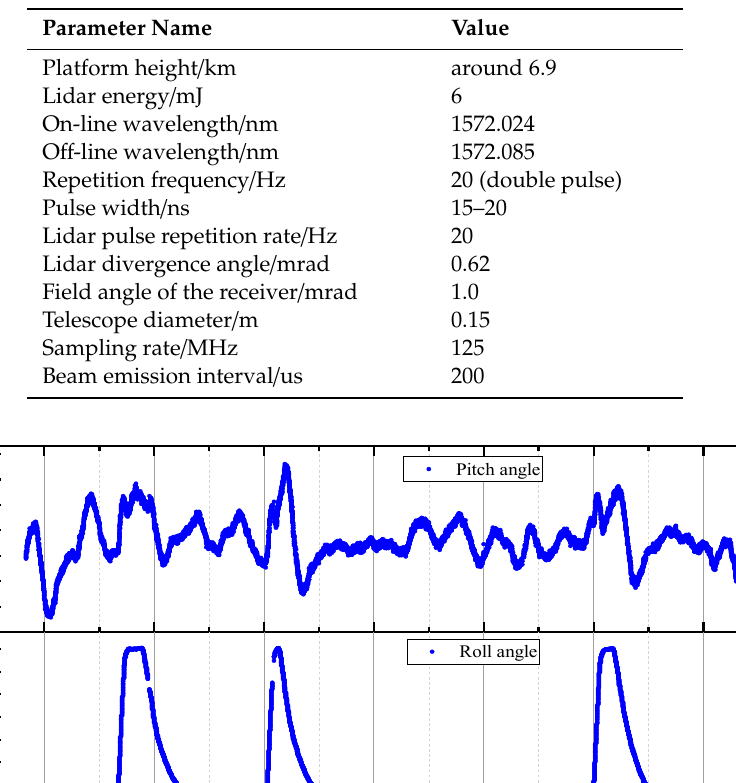
Table 2. Parameters of the used IPDA Lidar.